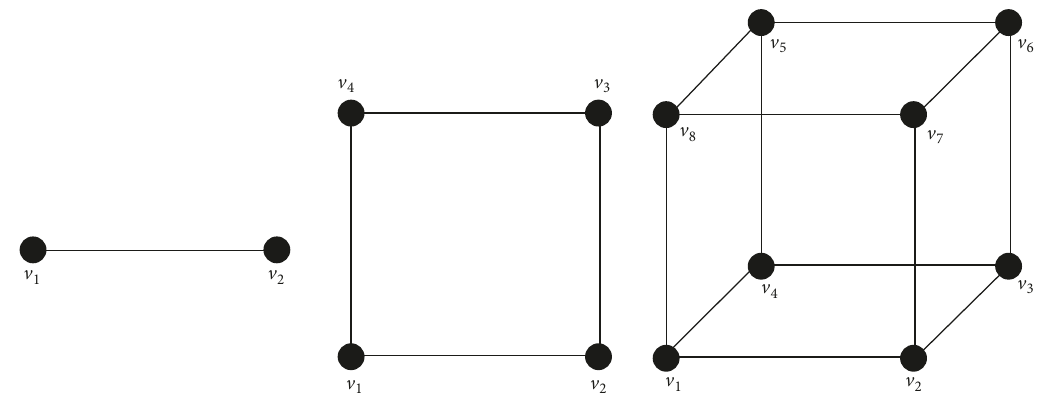
Figure 1: 𝑛 - Cube graphs with fixed vertex ordering for 𝑛 = 1, 2, 3 .